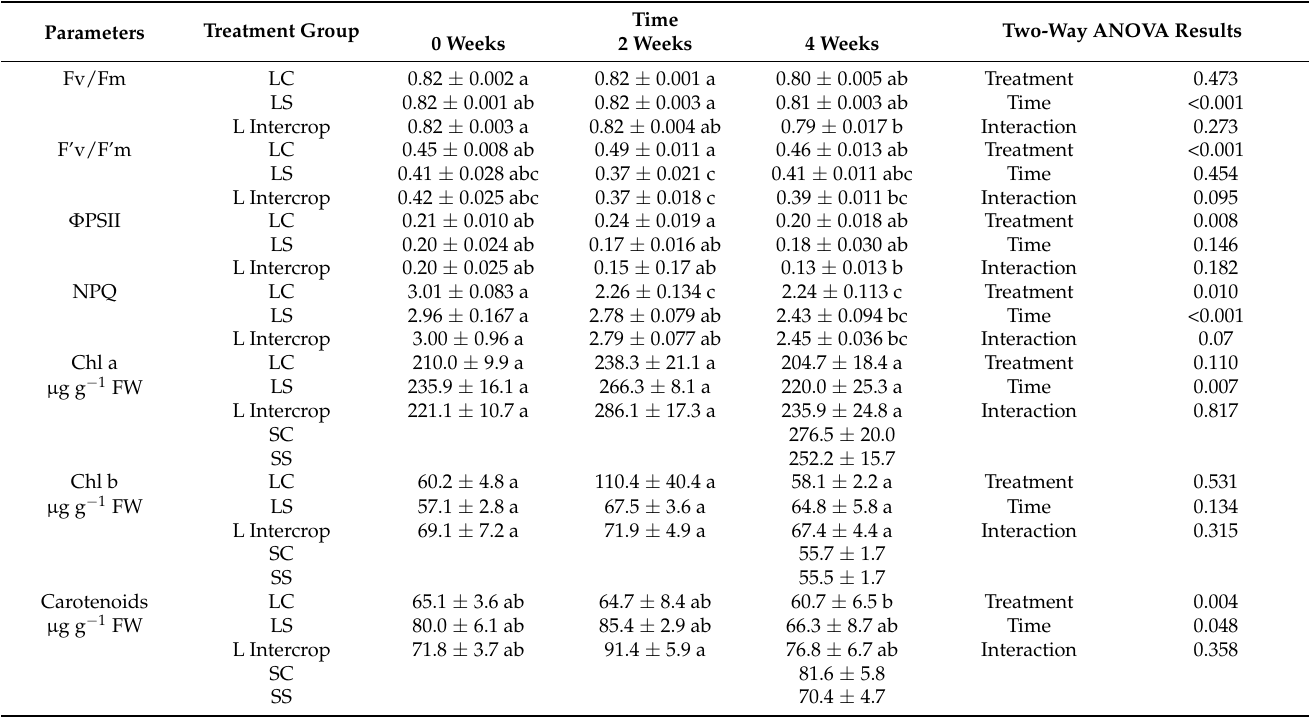
Table 3. Physiological parameters investigated in L. sativa (Time 0, 2 and 4) and S. soda (Time